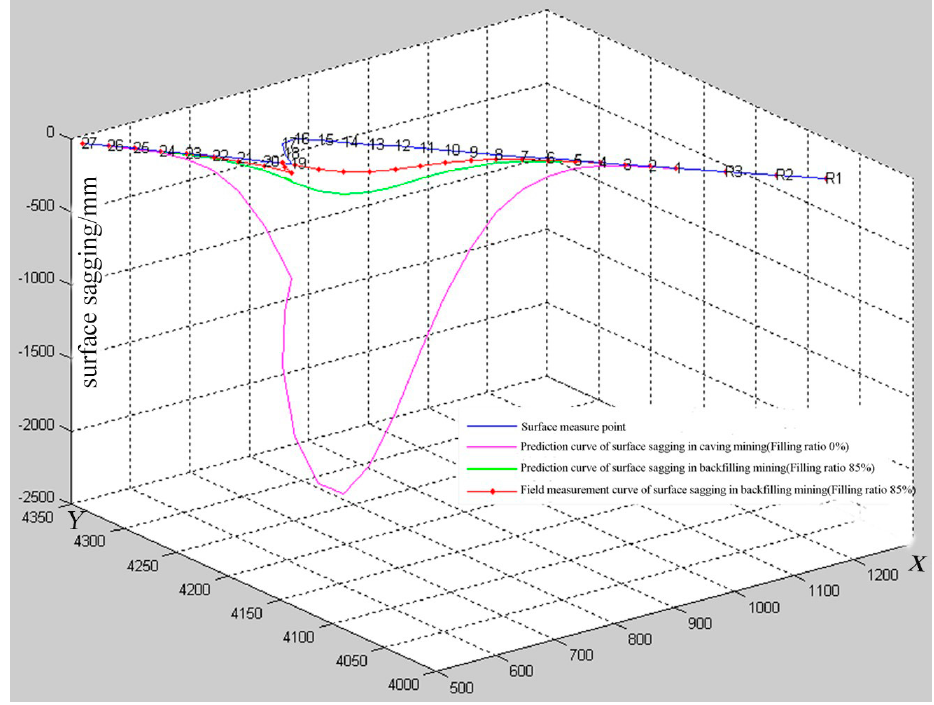
Figure 22. Surface sagging predicted and field measurement curves of Panel 13080.